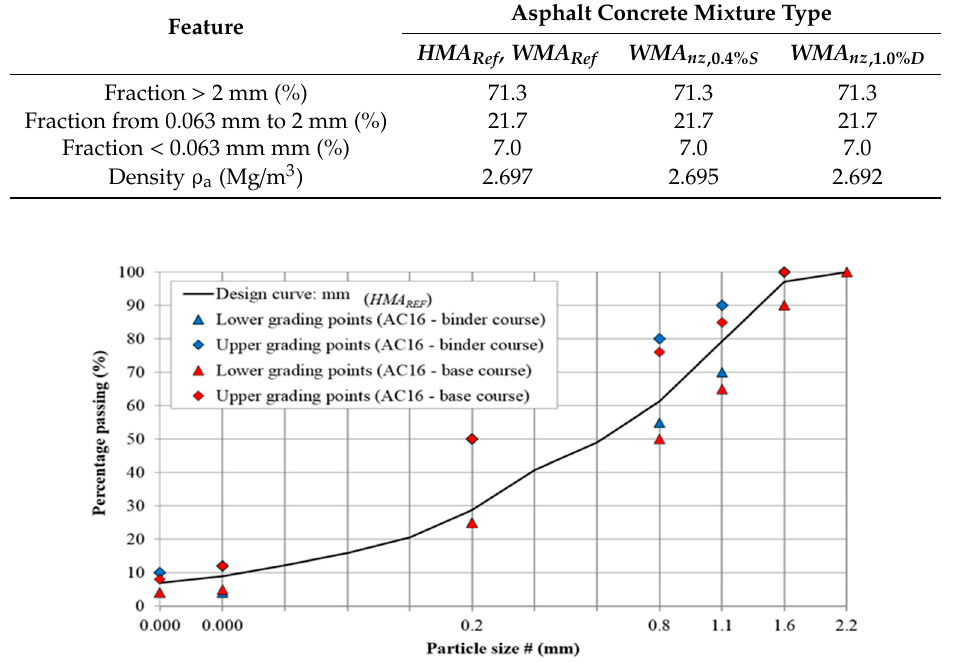
Table 6. The digest of sieving analysis of the designed asphalt concrete mixtures.